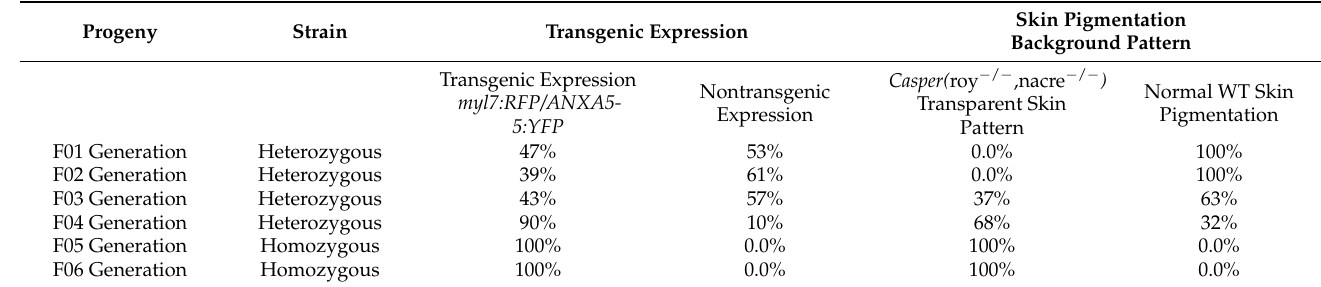
Table 1. Summary of the newly developed strain Tg(UAS:SEC-Hsa.ANXA5-YFP,myl7:RFP) ; Casper( roy − / − ,nacre − / − ) gmc1 . Progeny